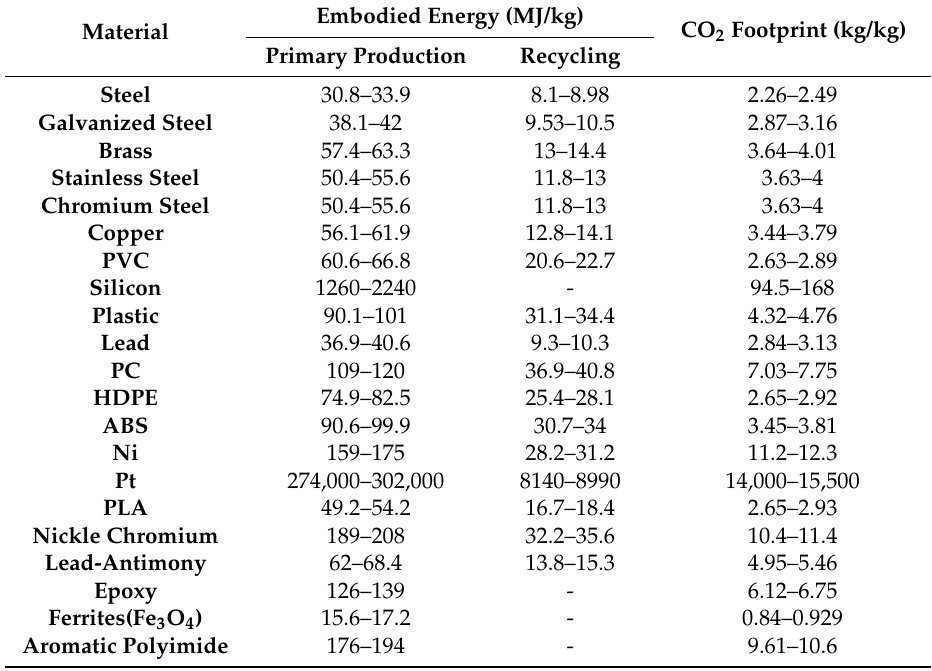
Figure 3. Vertical recyclebot. The white hopper is on the upper left and the black spooler is on the upper right. The motor in the upper middle drives an auger that feeds plastic into the hot zone (insulated in yellow). Filament is produced and looped through a light sensor to maintain the loop length, and thus the filament diameter, automatically. In this setup, the length and diameter can be measured continually. Table 8. The embodied energy of the materials needed in a recyclebot used in the input of the LCA (CES database [57]).